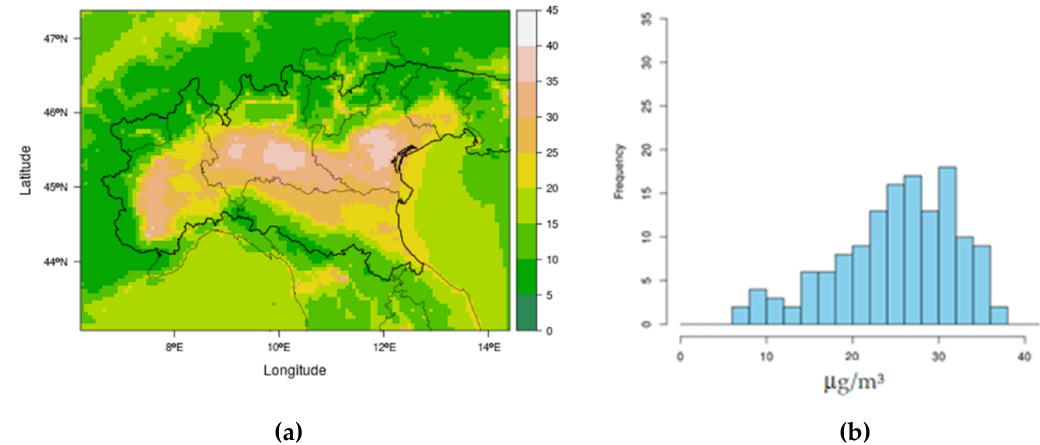
Figure 8. Baseline PM 10 : ( a ) ground field of annual average concentration ( μ g/m 3 ); ( b ) frequency distribution of annual average concentration in background stations.